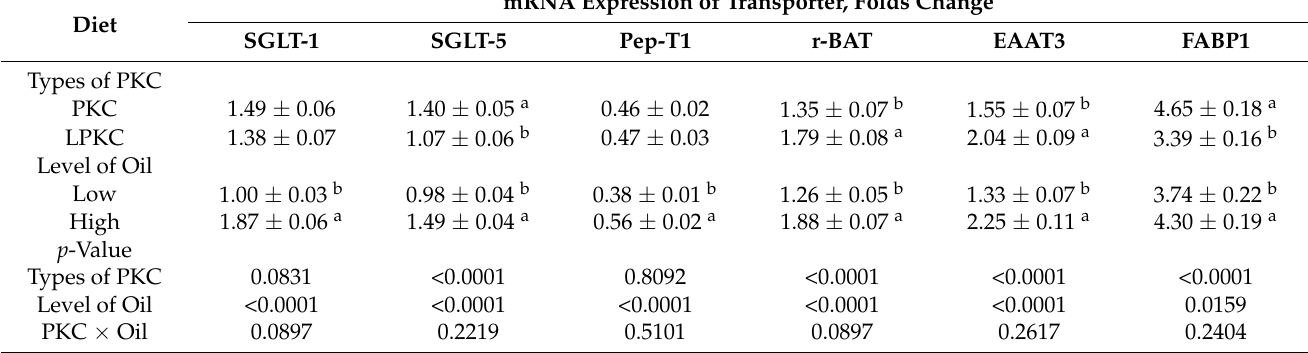
Table 7. Effects of feeding PKC and LPKC diets with different oil levels on mRNA expressions